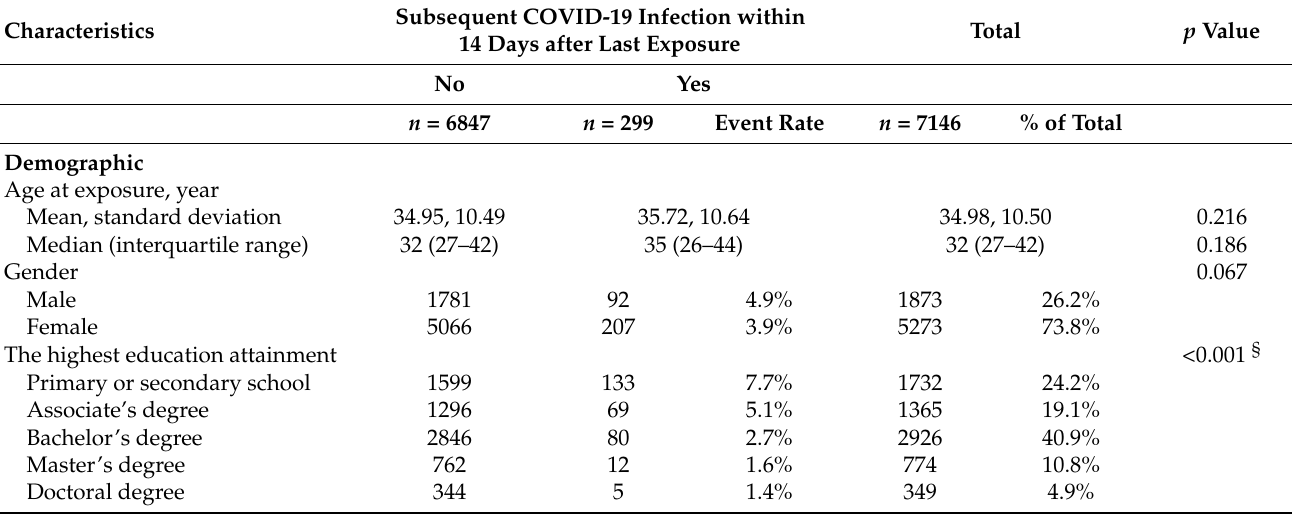
Table 1. Characteristics of occupational exposures to COVID-19 of hospital workers.